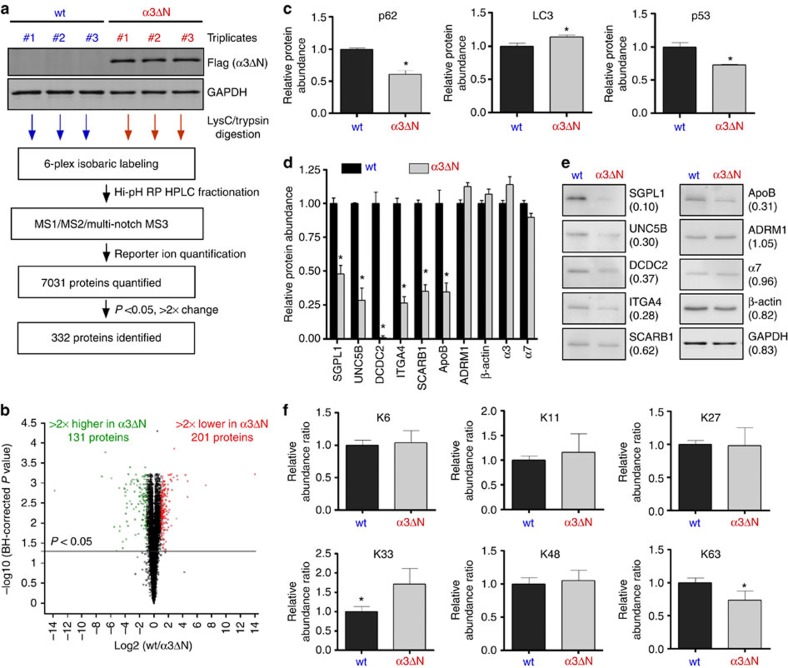
Identification and validation of changes in protein levels in
α3ΔN cells.(a) Overview of the quantitative TMT approach used to identify the
hyperactive proteasome-sensitive targets. Triplicates of whole-cell lysates
from wt and α3ΔN cells were individually labelled with
6-plex isobaric tags, mixed, and analysed by LC-MS3.
(b) Volcano plot of the 7,031 quantified proteins. Log2 ratios of
wt/α3ΔN cells are shown with black (<2
× change), green (>2 × increase in
α3ΔN) and red (>2 × decrease in
α3ΔN) dots. A threshold using a P value cutoff
(P=0.05) is shown in a black line. (c)
Representative TMS-MS3 data, quantifying and comparing p62,
LC3 and p53 levels in wt and α3ΔN cells. These data,
shown here as relative abundance ratios±s.d., are consistent with
the results of IB-based analysis in Fig. 3d.
(d) Hyperactive proteasome-sensitive target substrates, whose
functions are in cell motion, were quantified by TMT-MS3.
(e) Immunoblotting analysis of target substrates in d.
Quantitative ratios (wild type versus α3ΔN) are shown in
parentheses. (f) Relative abundance ratios of specific linkage types
of polyubiquitin chain from TMT-MS analysis. *P<0.05
(n=3, two-tailed Student's
t-test).